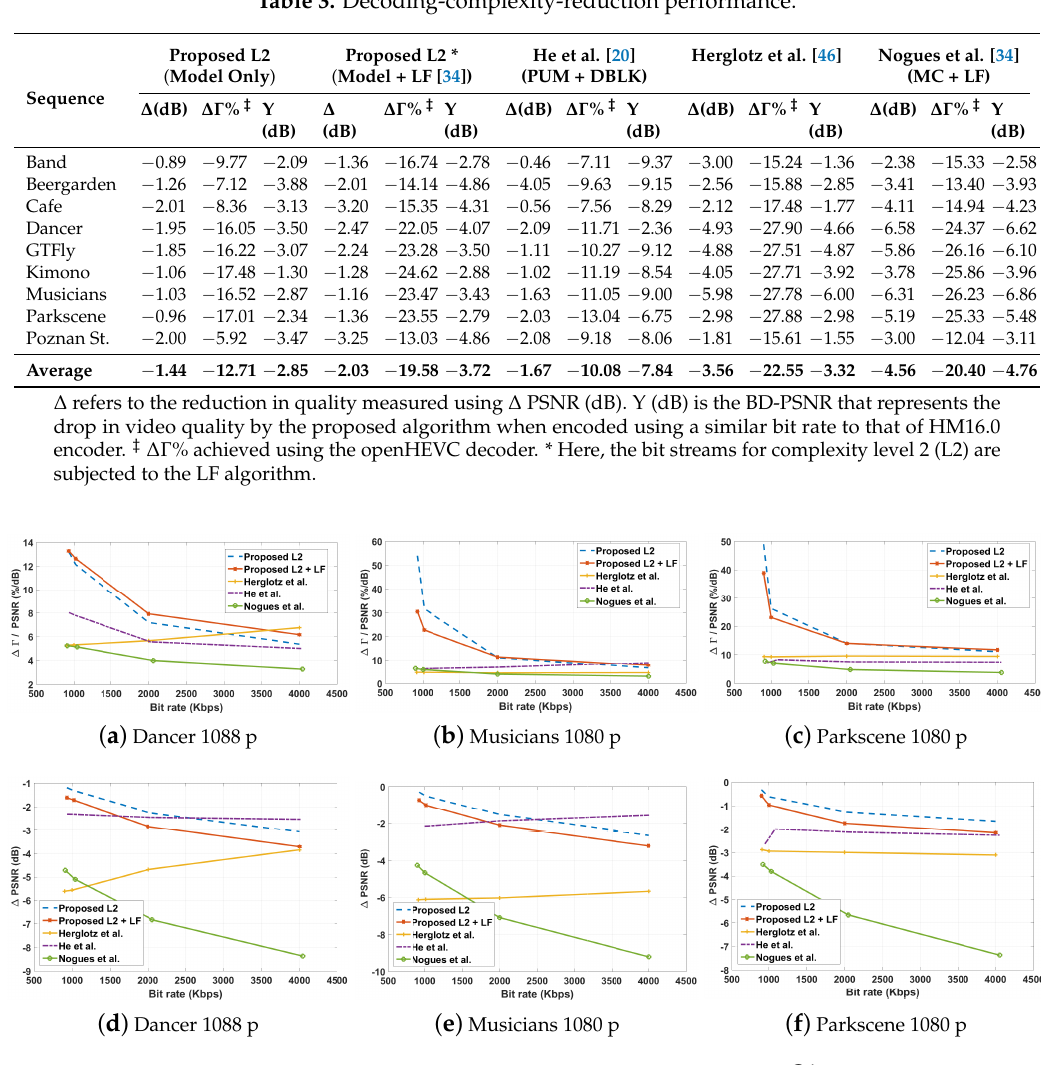
Figure 4. An illustration of the variation of the ∆Γ , ∆ PSNR ratio ( top row ), i.e., (cid:102) ∆Γ ( %/dB ) , and ∆ PSNR ( bottom row ), with respect to the bit